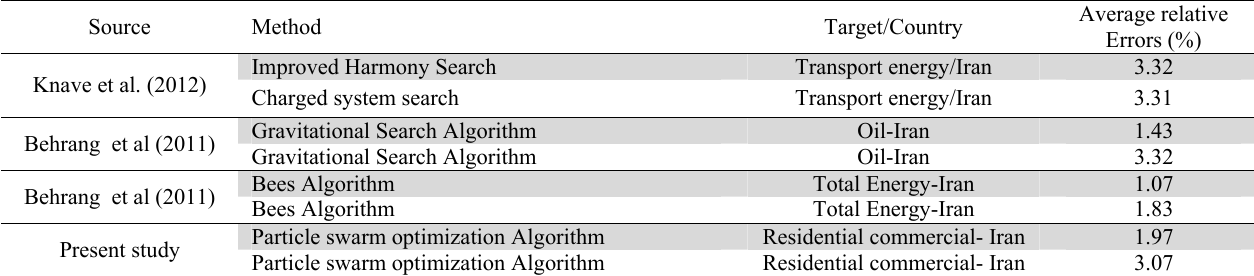
Comparison of different models presented in the literature and present study a